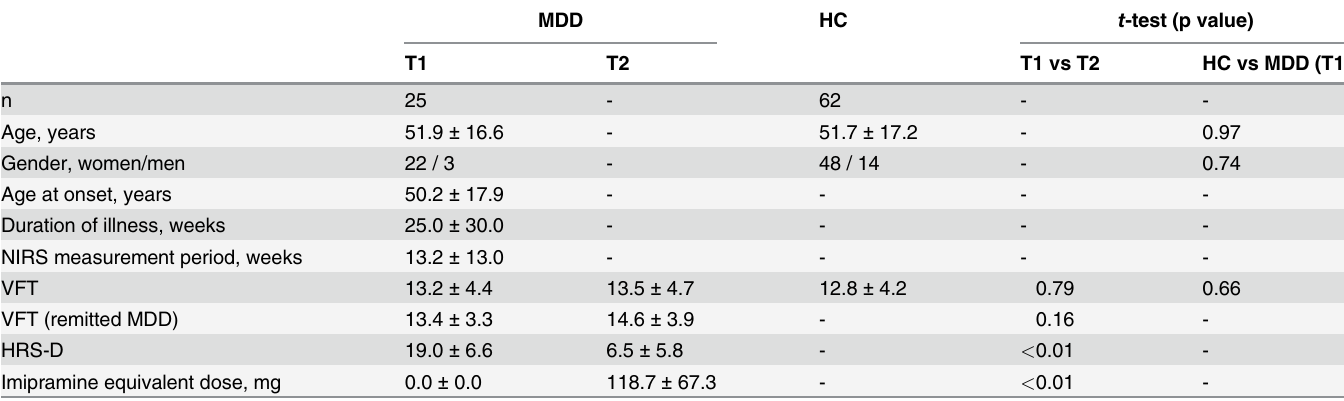
Table 1. Demographic and clinical characteristics.